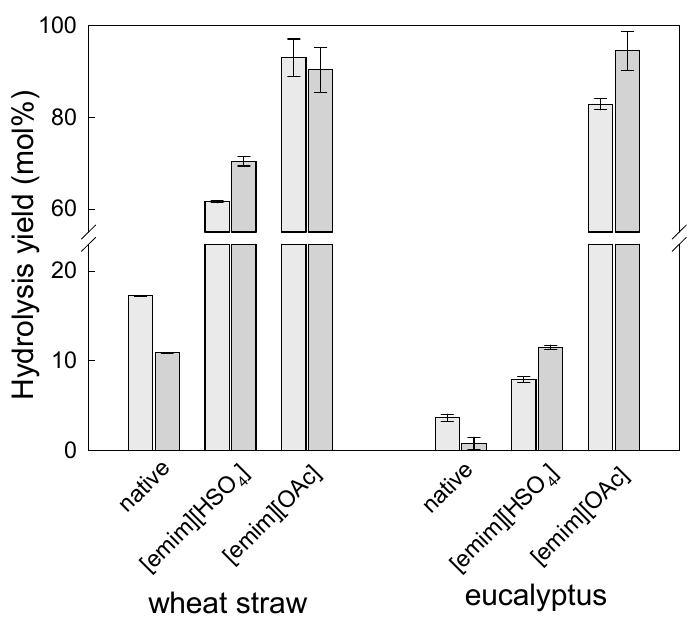
Figure 8. The enzymatic hydrolysis yield (glucan to glucose–light grey bar; and xylan to xylose–dark grey bar) of pre-treated wheat straw and eucalyptus residues solids produced in processes at 140 °C with aqueous [emim][HSO 4 ] (30 wt.%, 90 min) and [emim][OAc] (2 h). The enzymatic hydrolysis yield for native biomasses is presented for comparison.